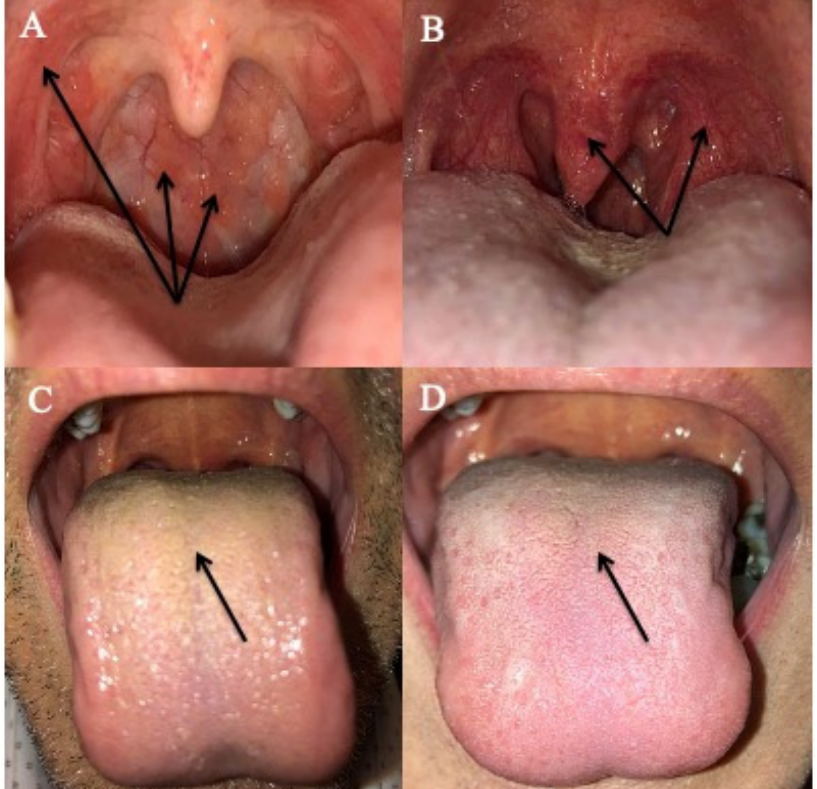
Figure 1. Oral and Oropharyngeal Findings Associated with LPR. Pharyngeal erythema ( A ), anterior pillar erythema ( A , B ) and uvula erythema ( B ) are signs easily identified in primary care practice (1,2) accounting for 89.5, 91.0 and 54% of cases. Coated tongue ( C ) is found in 49.4% of patients and may significantly improve through treatment ( D ). However, the primary care physician had to keep in mind that some patients have a significant improvement of symptoms but these signs may persist over time